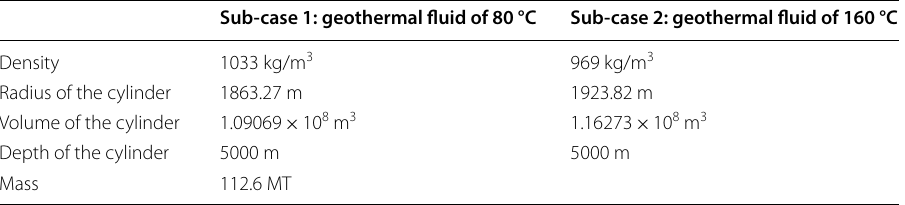
We consider the real injection depth of 5000 m Table 3 Values of the radius (in m), the volume (in m 3 ) and the mass (in kT) of the cylinder for a geothermal fluid of 80 °C (sub-case 1) and 160 °C (sub-case 2)